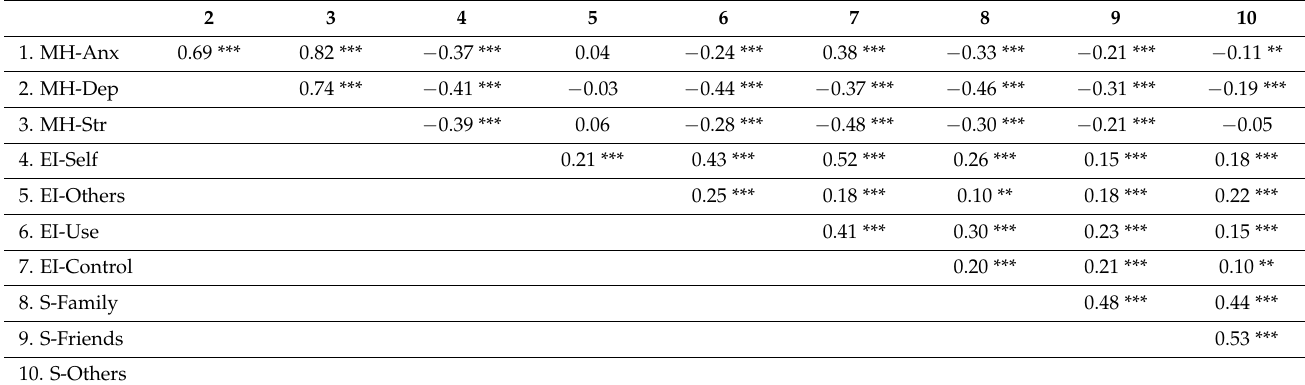
Table 2. Pearson’s correlation coefficients among EI, SS, and MH dimensions.